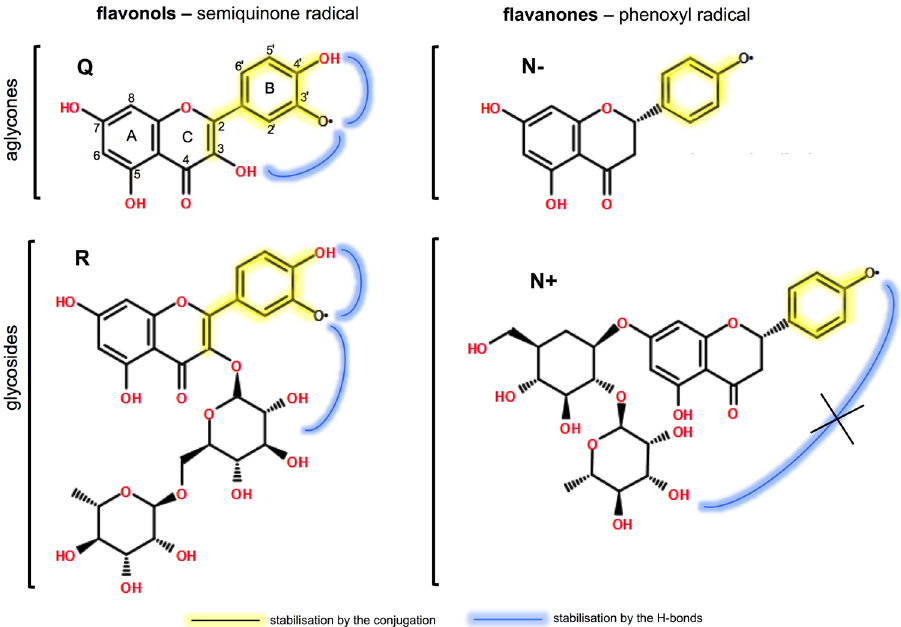
Figure 1. The chemical structures of radicals formed upon the first stage of oxidation of flavonoids under study with indicated redox-active moieties and the possible sites of intramolecular H-bond formation. The hydrogen bonds may be formed directly or via water molecule depending on structural circumstances. The abbreviated names of flavonoids refer to: Q-quercetin, R-rutin, N−-naringenin, N+